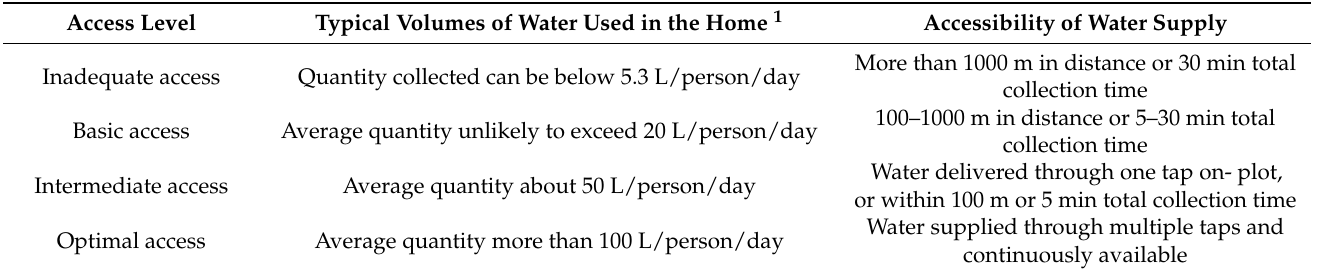
Table 1. Water supply categories by consumption and accessibility (data: